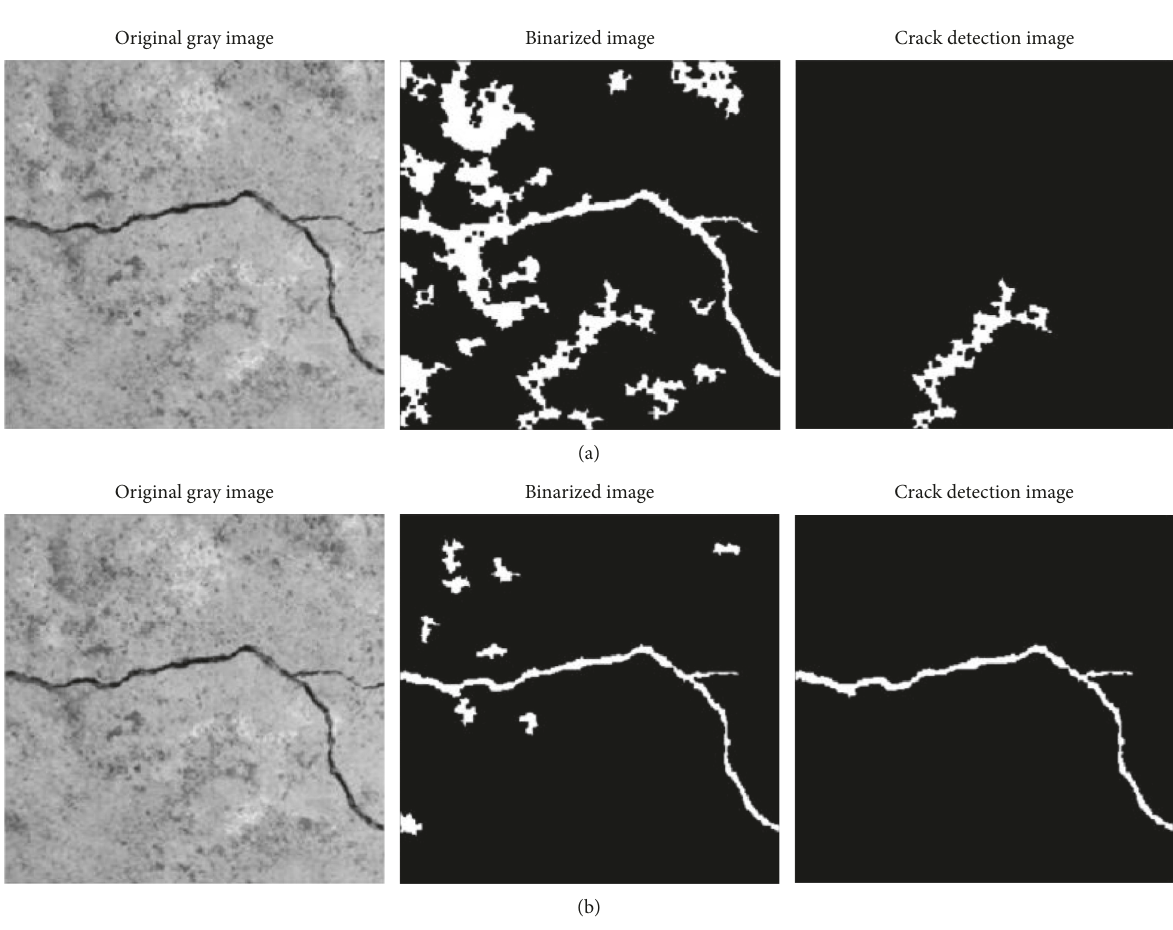
Figure 9: Testing image no. 4 using (a) the Otsu method and (b) the M2GLD